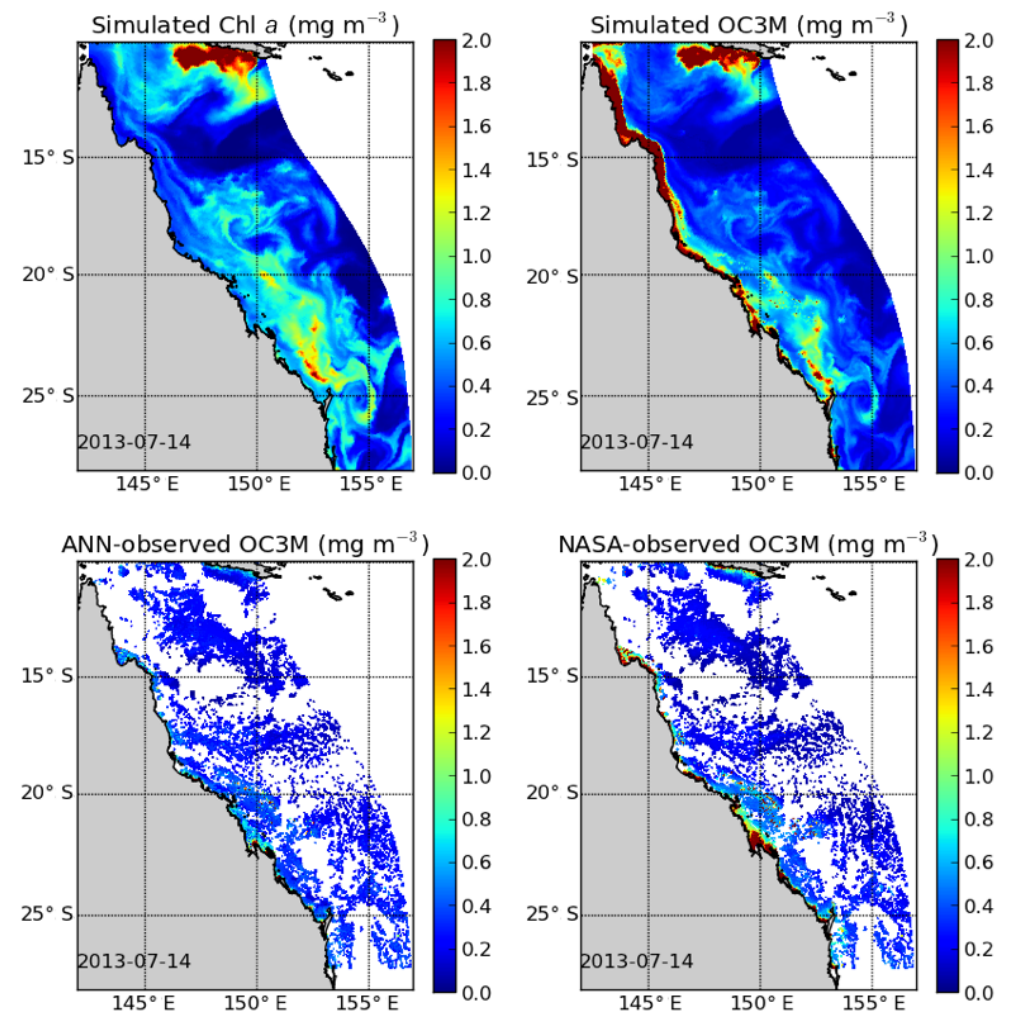
Figure 4. Simulated surface Chl a (mgm − 3 ) of the non-assimilating control run (top left) and the simulated OC3M (top right) derived from the simulated remote-sensing reflectance for 14 July 2013. The observed OC3M with ANN-derived observed remote-sensing reflectance (bottom left) and NASA-derived observed remote-sensing reflectance (bottom